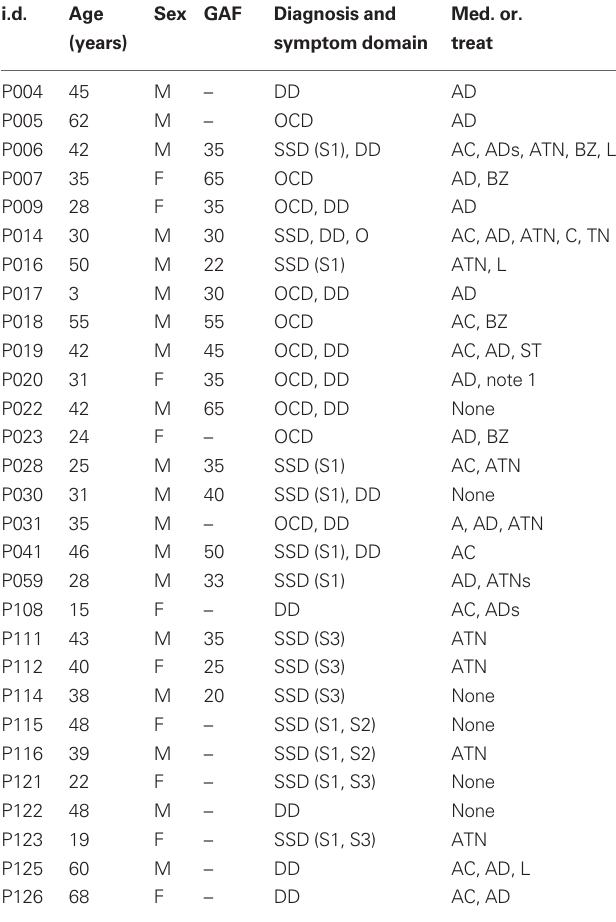
Table 1 | Demographics, diagnosis, medication class for neuropsychiatric patients.